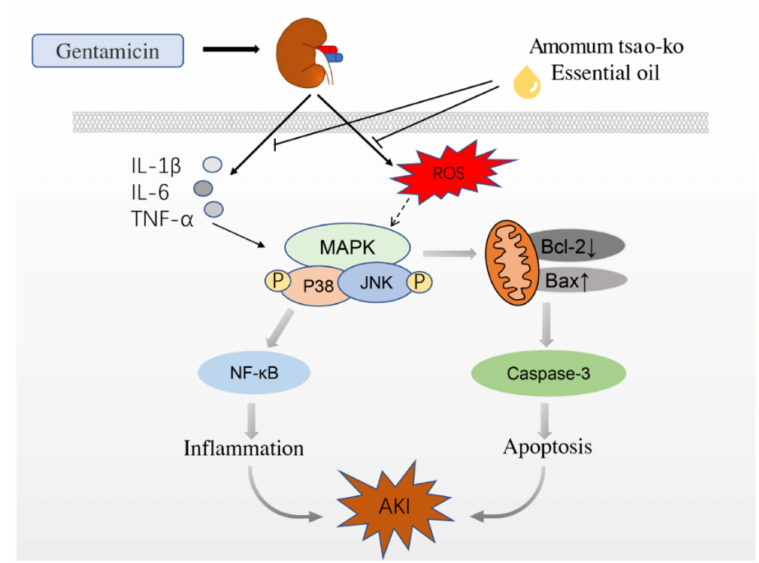
Figure 8. How AO affects the speculative mechanism of AKI caused by